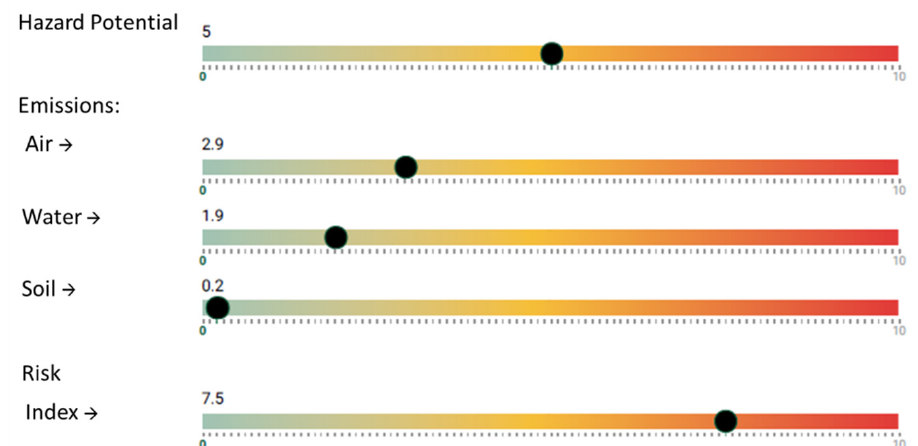
Figure 7. Excerpt from the report generated with the NanoSerpa v1.0 app for a SiO 2 nanoparticle leak from a vacuum cleaner. These results apply only to the exposure area where the events studied have occurred.